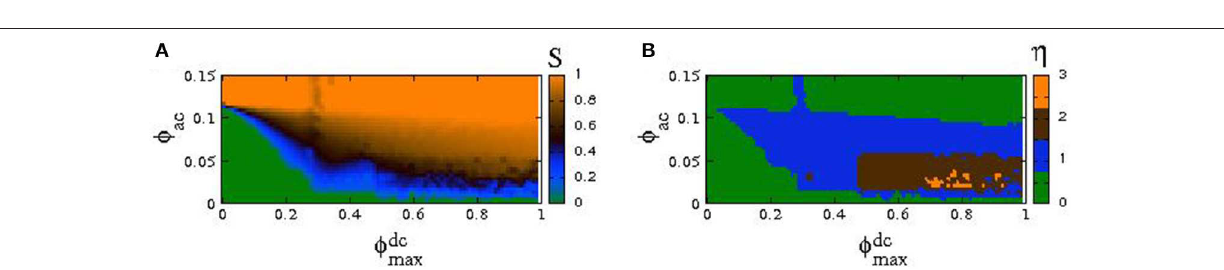
FIGURE 13 | The index of incoherence S (A) and the chimera index η (B) are mapped on the φ ac n 0 4, δ 10 − 4 . = =